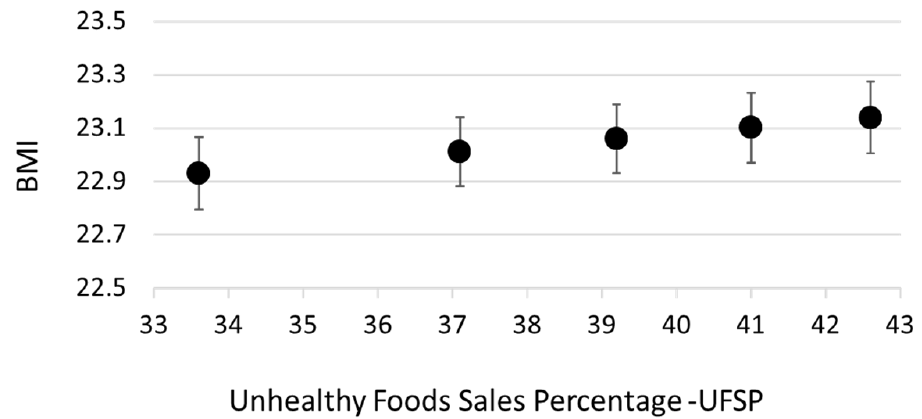
Figure 1. Associations between unhealthy food sales percentage and the odds of being ( A ) over- weight (including obese) or ( B ) obese. Odds ratios from logistic regression models (ref = Q 1). Mod- els adjusted for sex, age group, and individual-level physical activity, as well as local-authority- level deprivation and ethnic mix.